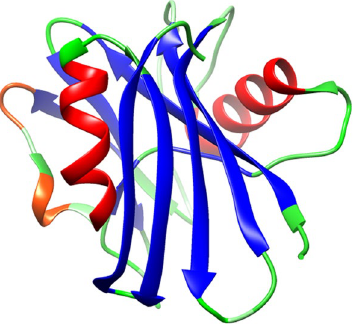
Figure 2. S-Pred SS8 predictions mapped on the 7,8-dihydro-8-oxoguanine triphosphatase (PDB ID: 5WS7) structure. The color codes for α-helix (H), 3 10 -helix (G), β-strand (E), turn (T), bend (S), and others (C) are red, orange-red, blue, green, light green, and lime green, respectively. It should be noted that none of the residues were predicted as π-helices (I) or β-bridges (B).